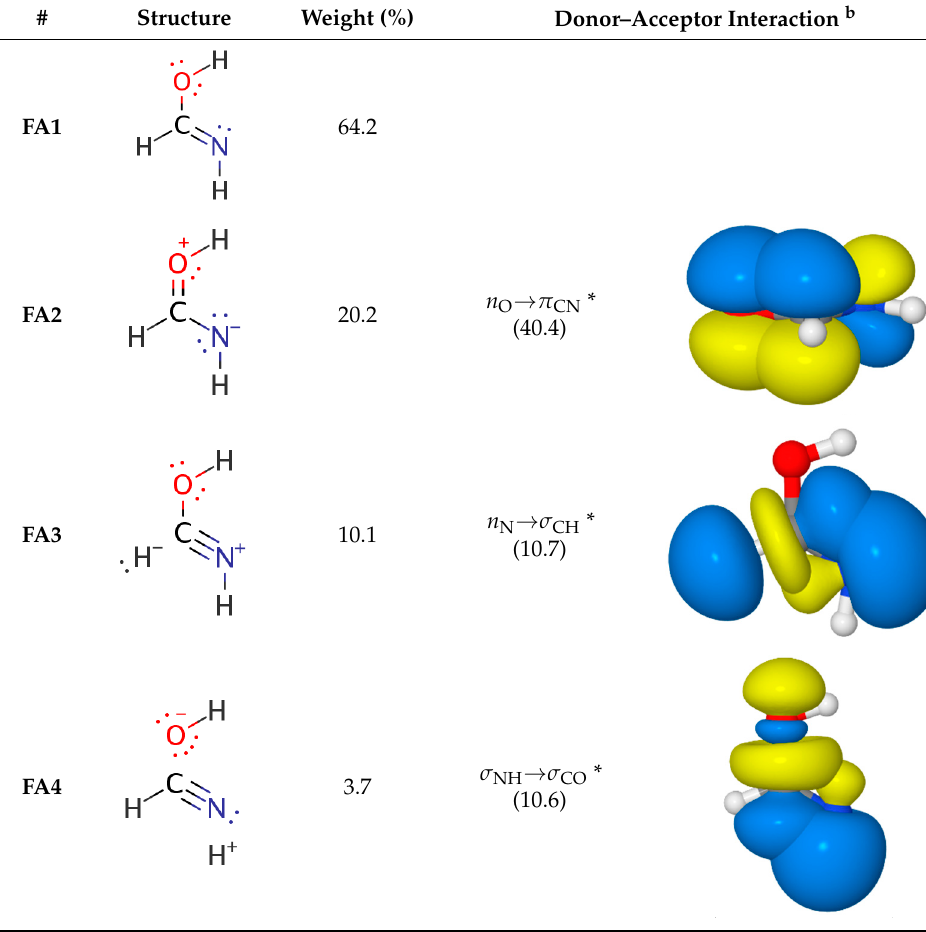
Table 4. NRT resonance hybrid of formimidic acid a .